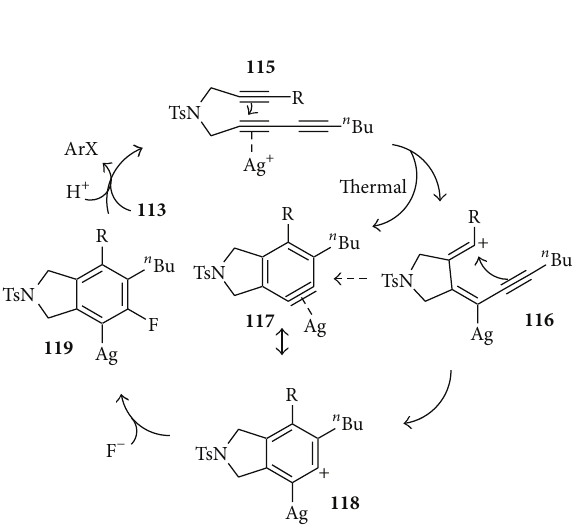
Scheme 26: A proposed reaction mechanism for compound 108